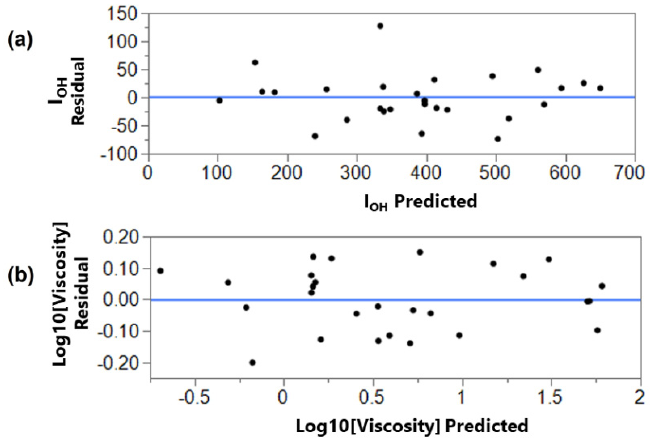
Figure 6. Plots of Residual versus predicted values for ( a ) I OH , ( b ) Viscosity. The adequacy of the fitted regression model for I OH and viscosity was verified by ANOVA (Analysis of Variance) using the Fisher F-test and its associated probability ( p value) for a 95% confidence level.